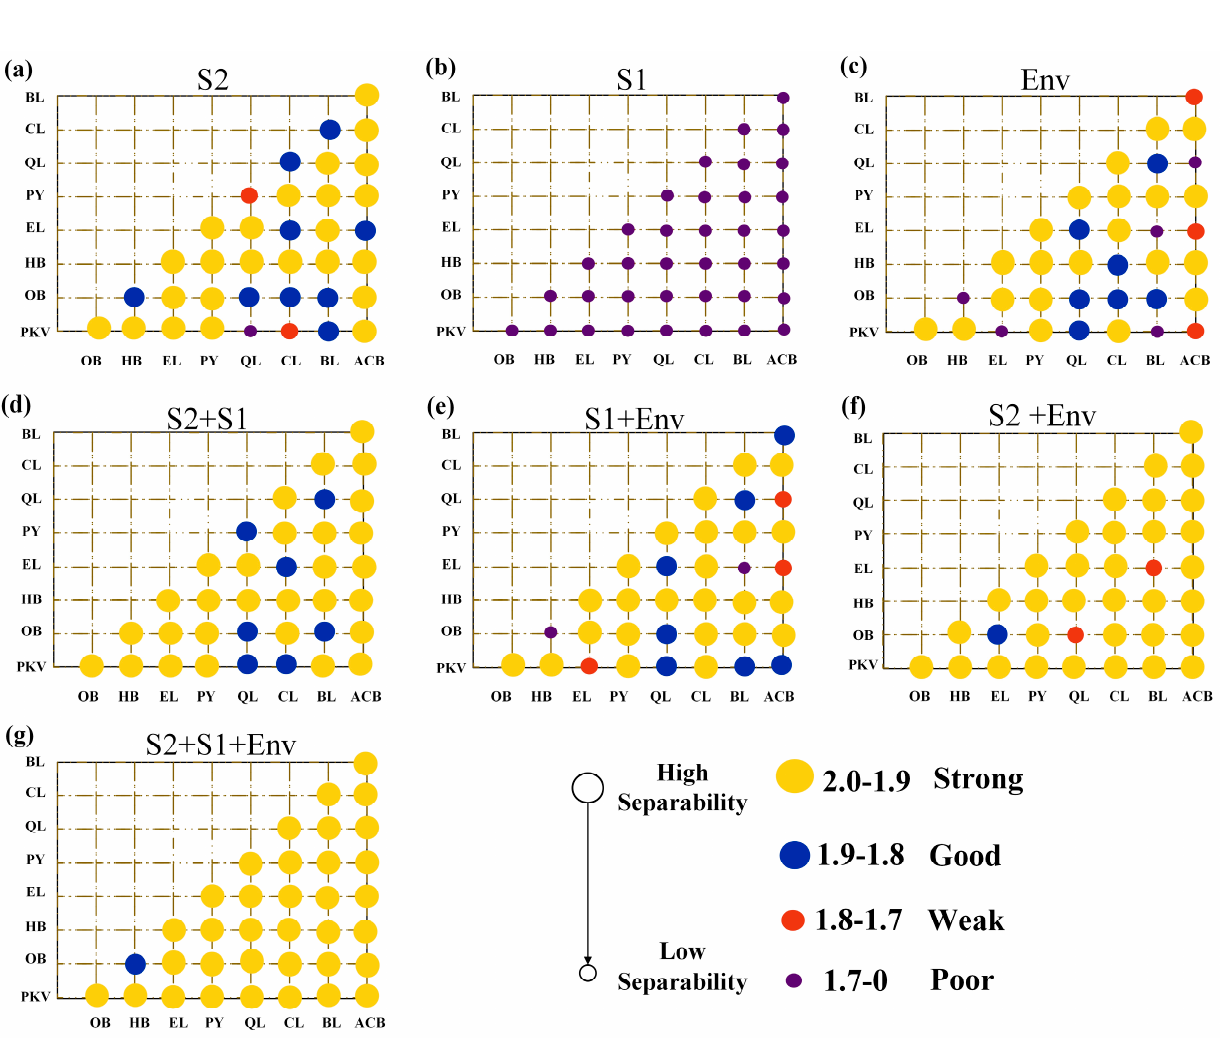
Figure 9. Class separability results derived based on the JM distance: ( a – g ) represent case 1–case 7.